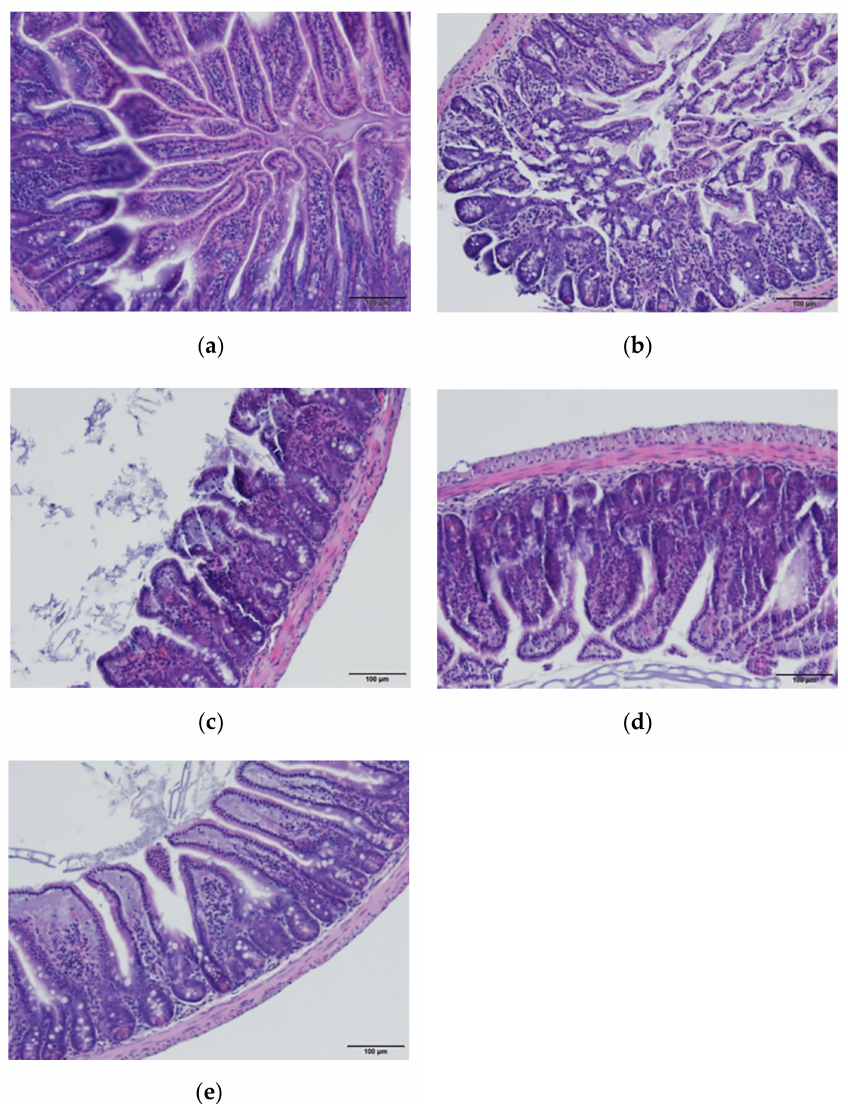
Figure 8. Representative images of H&E staining in colon sections of different treatment groups. ( a ) Normal control, ( b ) model control, ( c ) positive control, ( d ) fermented millet bran, ( e ) millet bran porridge